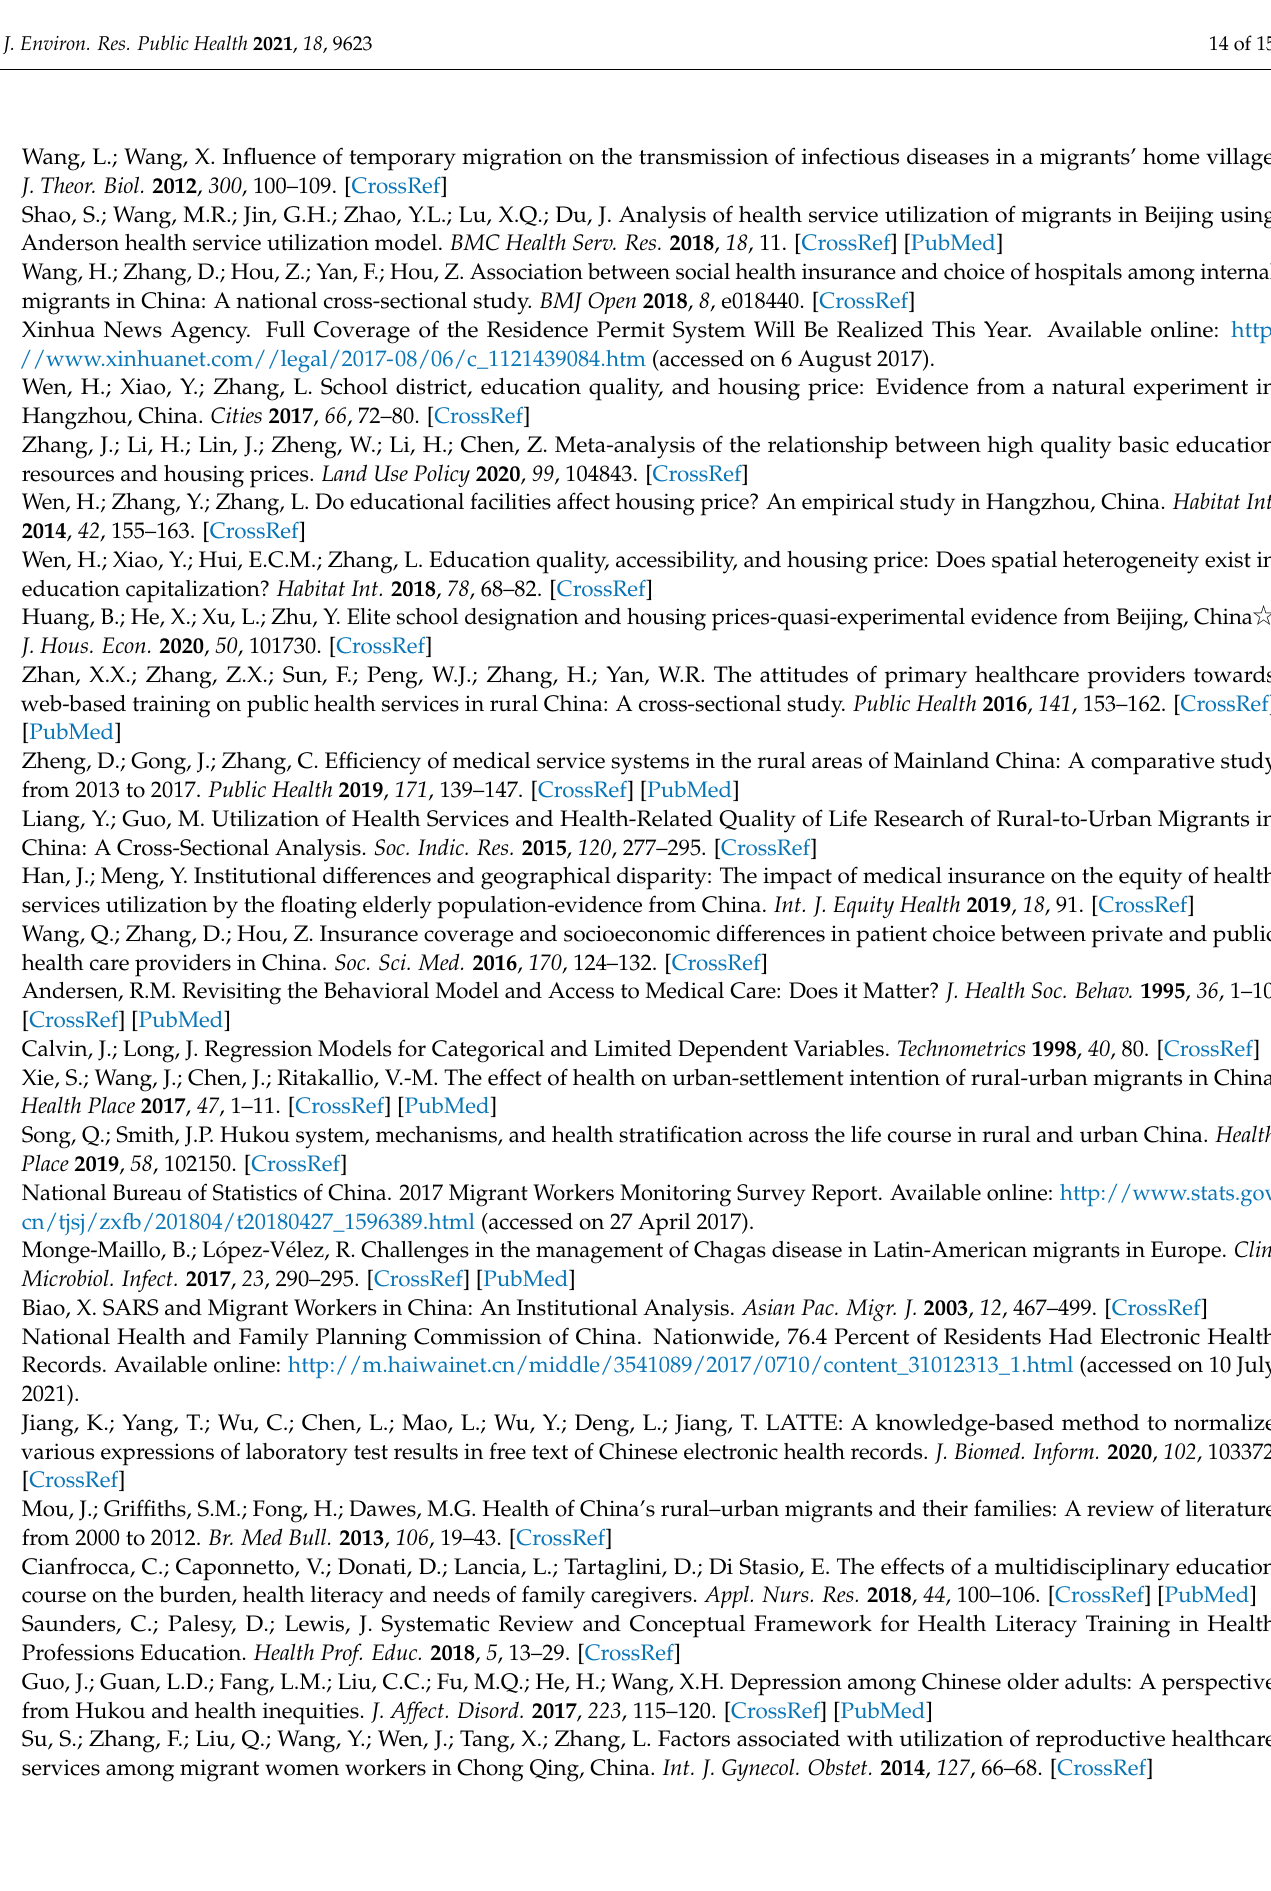
Table 259: wasysym Geometric